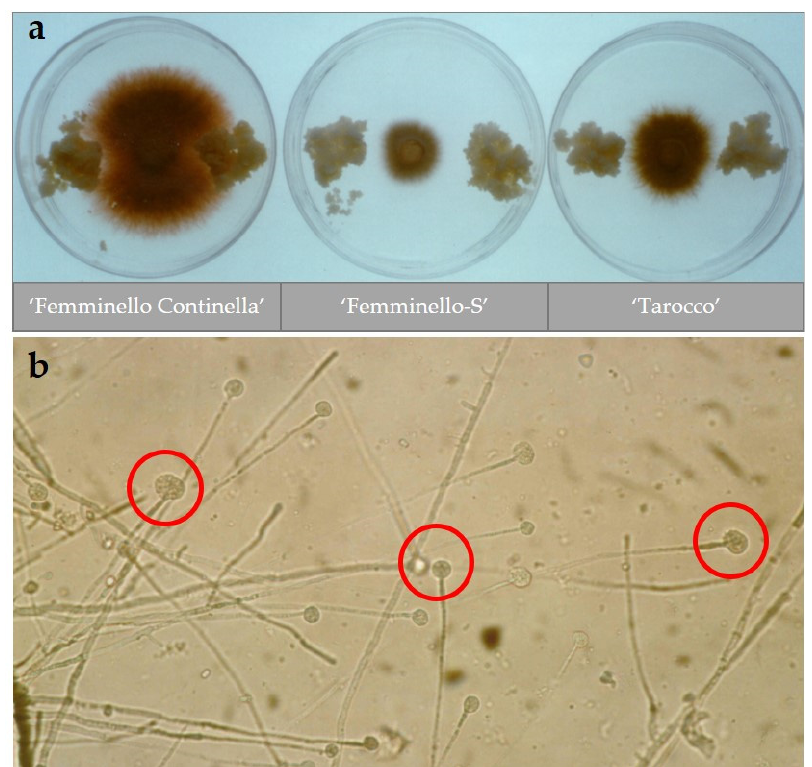
Figure 2. In vitro activity of ‘Femminello-S’ lemon callus. ( a ) Plenodomus tracheiphilus growth on MT medium in the presence of 30-day-old citrus calli (from left: ‘Femminello Continella’ lemon, ‘Femminello-S’ lemon, and ’Tarocco’ sweet orange). Calli were cultured for 30 days and then inoculated and co-cultured with the fungus for 10 days. The tolerant genotypes ‘Tarocco’ and ‘Femminello-S' showed inhibition of the fungal growth, in contrast to what was observed for 'Femminello Continella’ lemon. ( b ) P. tracheiphilus hyphae tips lysing after 5 minutes from the application of 10 µg of proteins extracted from the culture medium of ‘Femminello-S’ lemon somaclone (circled in red). Adapted from Gentile et al. [34].